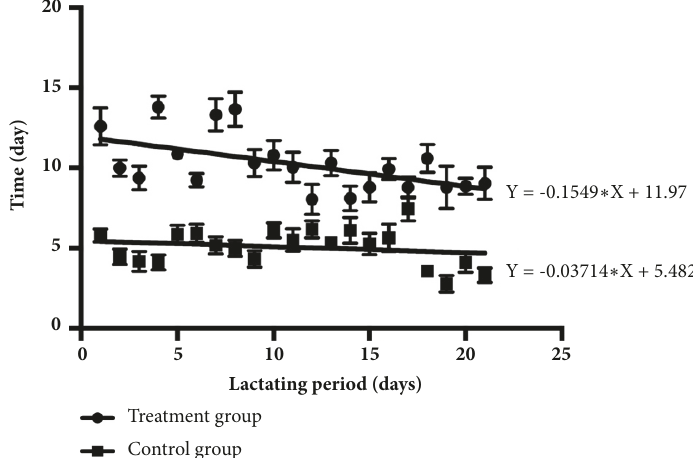
Figure 5: Frequency of times piglets came to a sow’s udder in the treatment group (exposed to AS sound) and the control group (not exposed to AS sound) each day of the lactation period.